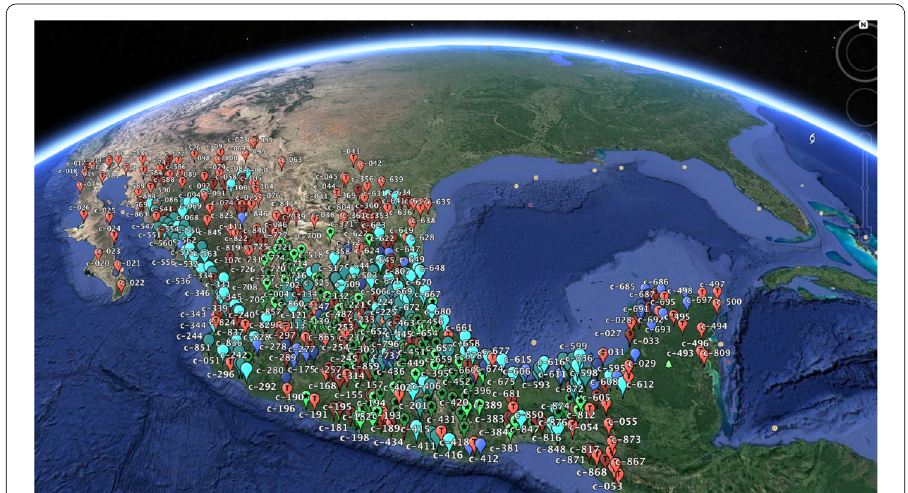
Figure 6 Distribution of nodes in the Mexican Republic